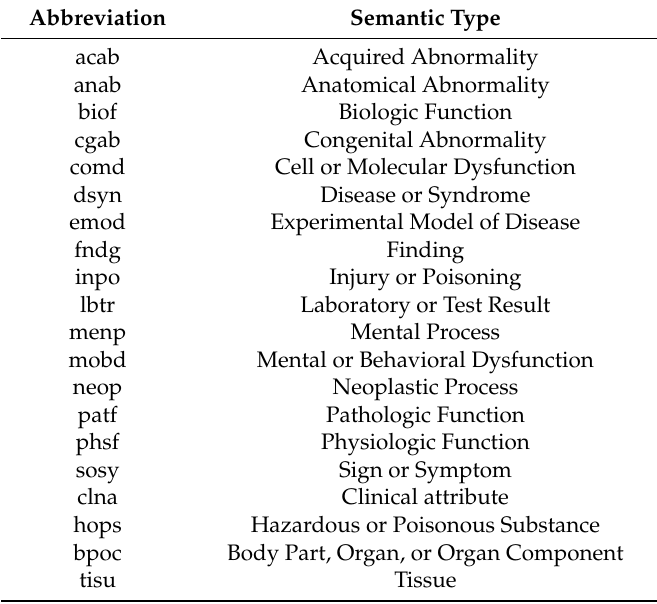
Table 1. Health effects-related UMLS semantic types. Among 135 semantic types, the following 20 semantic types were selected as related to health